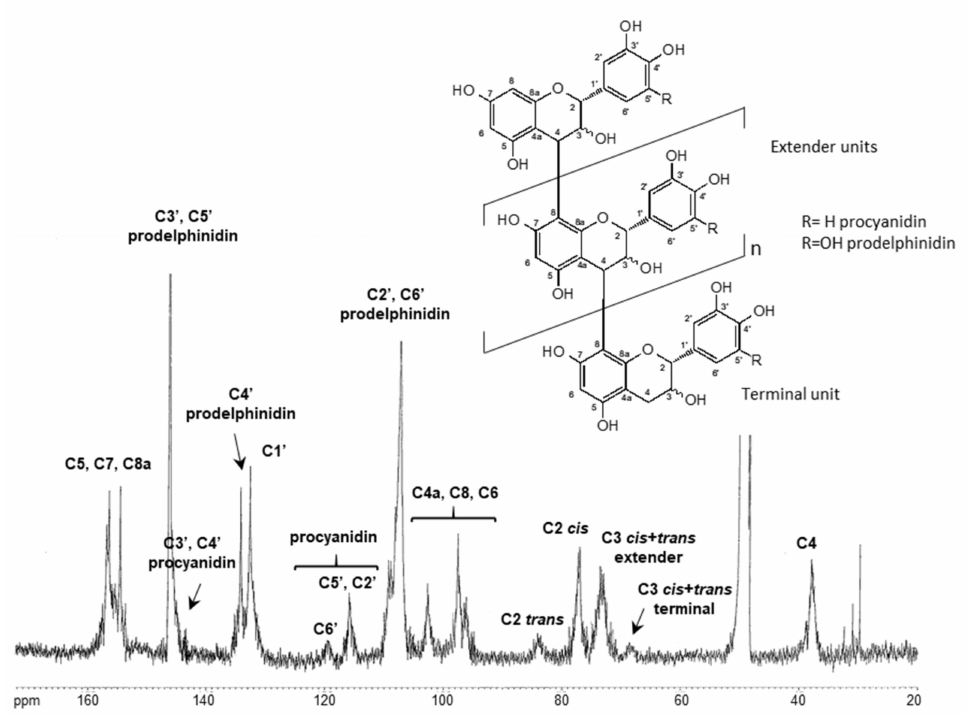
Figure 3. 13 C-NMR spectrum (CD 3 OD) of condensed tannins from H. coronarium